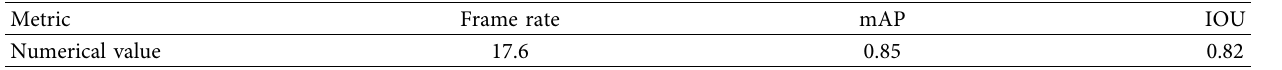
Table 4: Performance of the test model based on the RIRD-YOLOv3 algorithm.